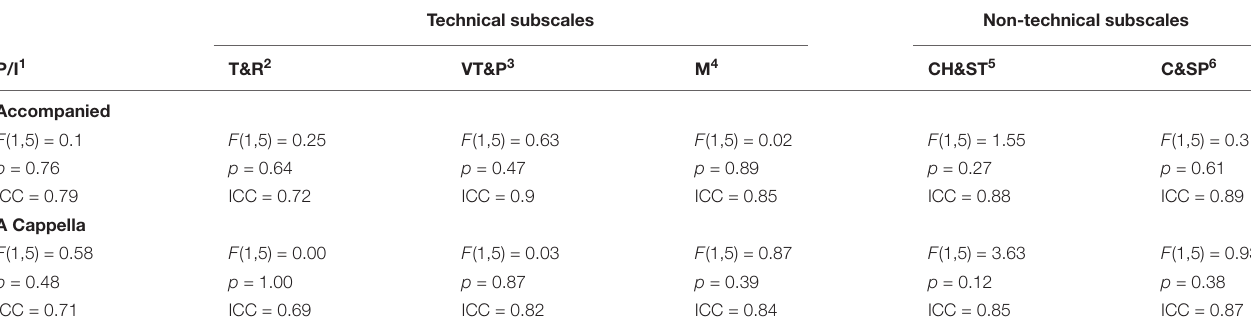
TABLE 3 | Results of ANOVA tests for the main effect of time on three judges’ ABRSM subscale scores for students’ accompanied and a cappella performances, and results of Intraclass Correlation Coefficient analyses using a two-way random model with absolute agreement among the judges.